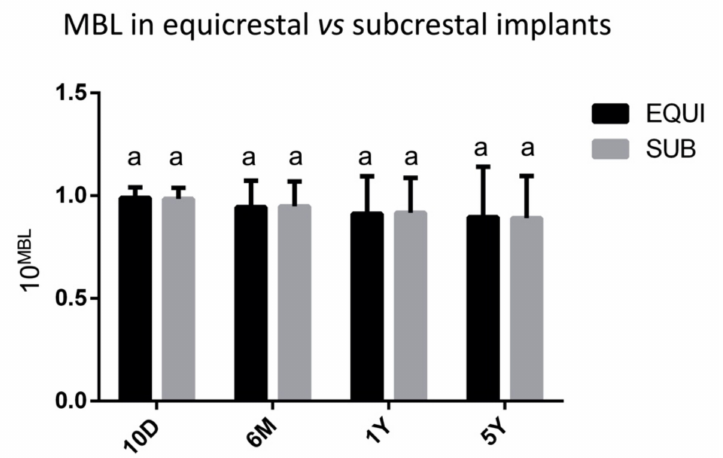
Figure 5. Marginal bone loss (MBL) calculated at 10 days (10D), 6 months (6M), 1 year (1Y) and 5 years (5Y) after surgical procedures, in equi- and subcrestal implants. Same letters indicate no statistically significant differences among groups ( p > 0.05). MBL values were submitted to a base 10 exponential data transformation, to deal with the numerous zero